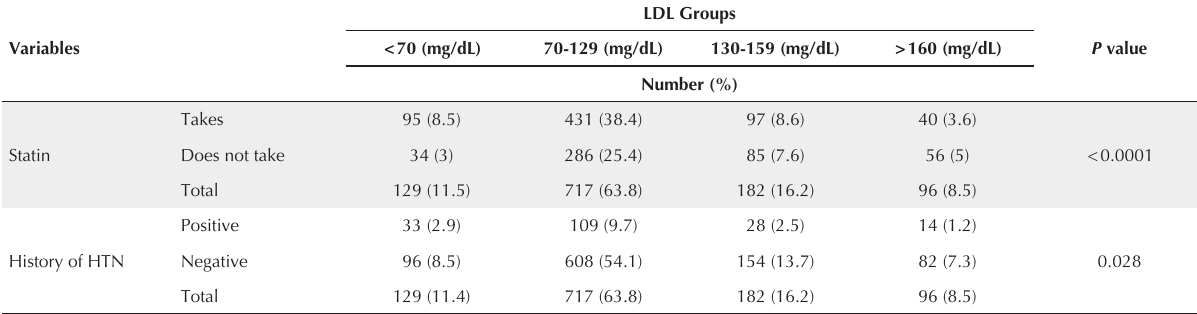
Table 2. Distribution of non-diabetic patients by statin intake and HTN in 4 LDL groups